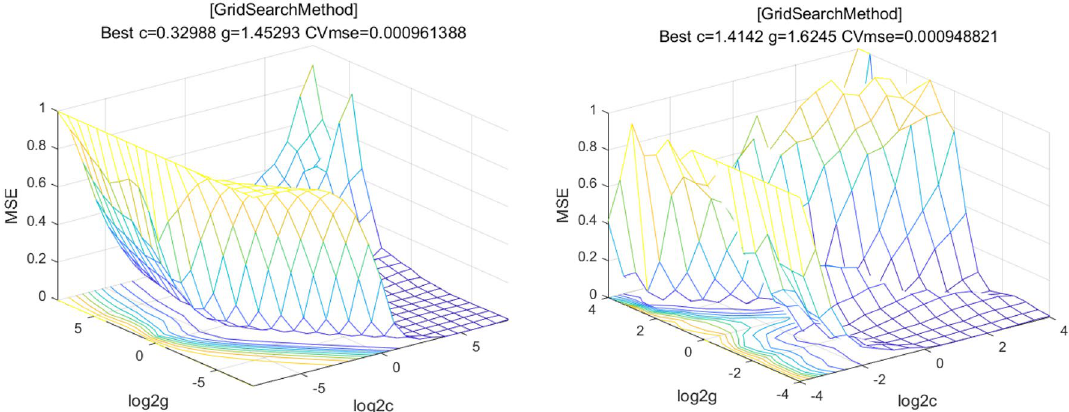
Figure 8. Result of parameter selection (rough selection diagram vs. fine selection map).